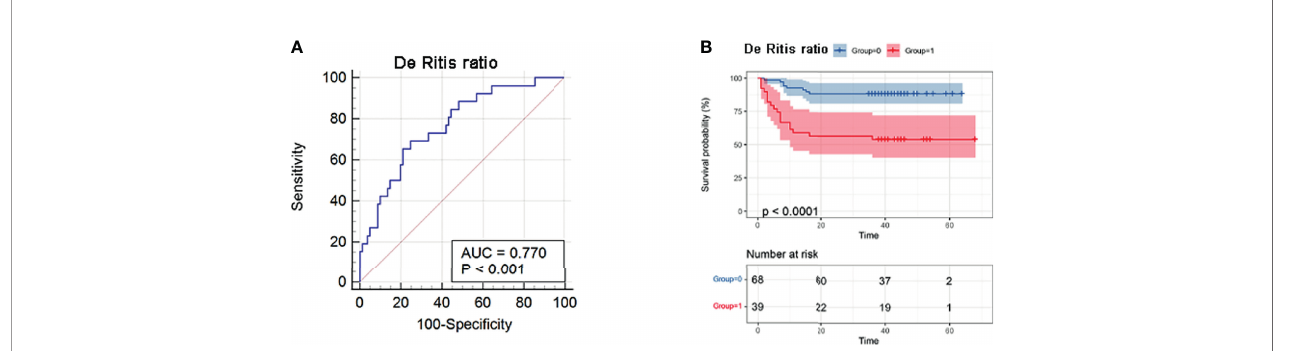
FIGURE 2 | Value of AST/ALT-ratio in predicting prognosis of SFTS patients. (A) Receiver operating curve (ROC)-analysis. The area under the curve (AUC) for survival regarding the AST/ALT-ratio was 0.770 (95%CI, 0.679-0.846). (B) Kaplan-Meier curves predicting survival, grouped by the cut-off value of